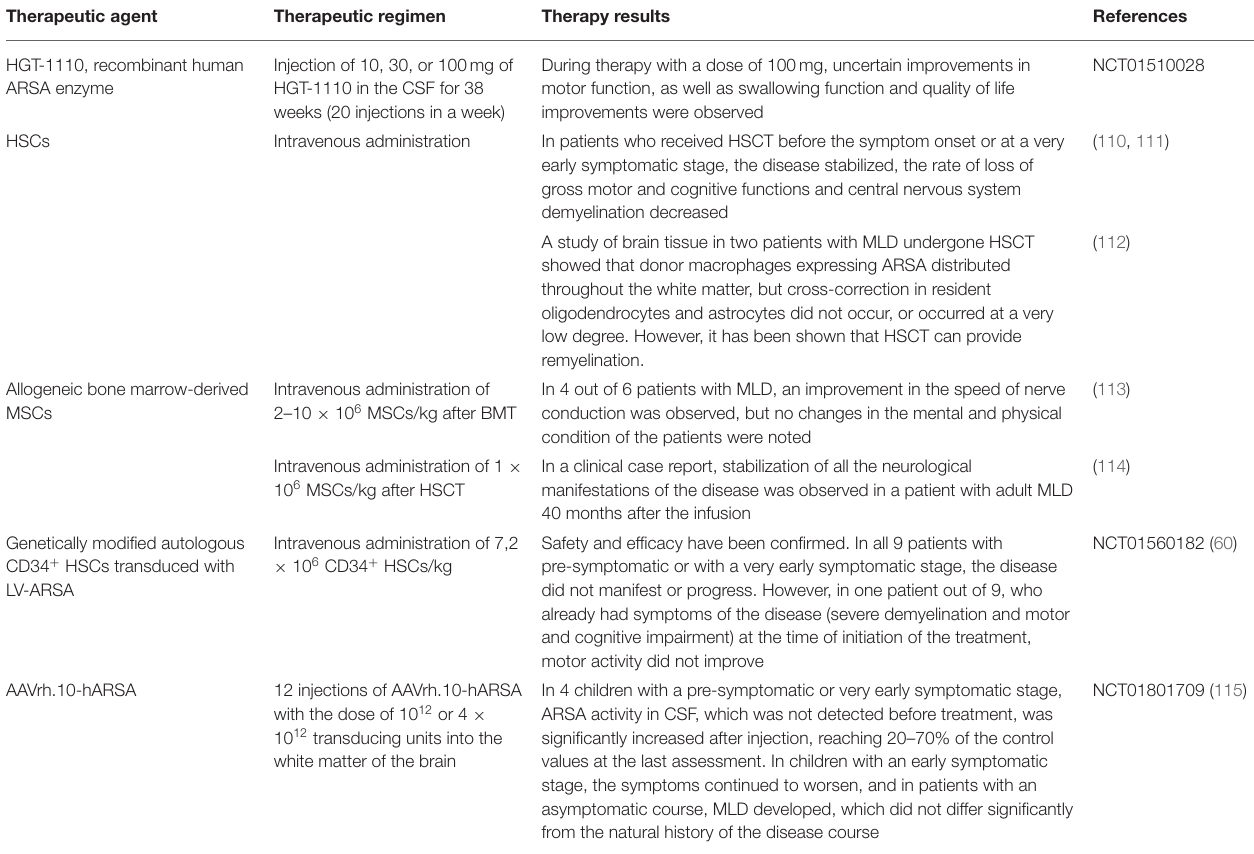
TABLE 2 | Clinical trials of the therapeutic approaches to treat